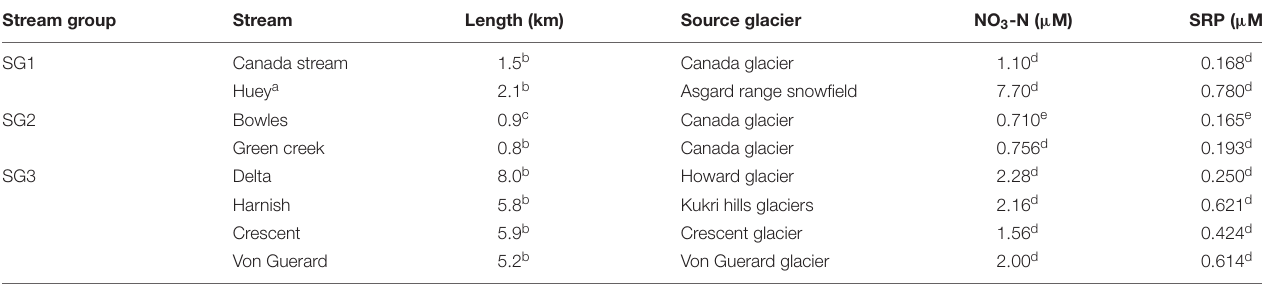
TABLE 1 | Characteristics of streams where source data were collected. Stream